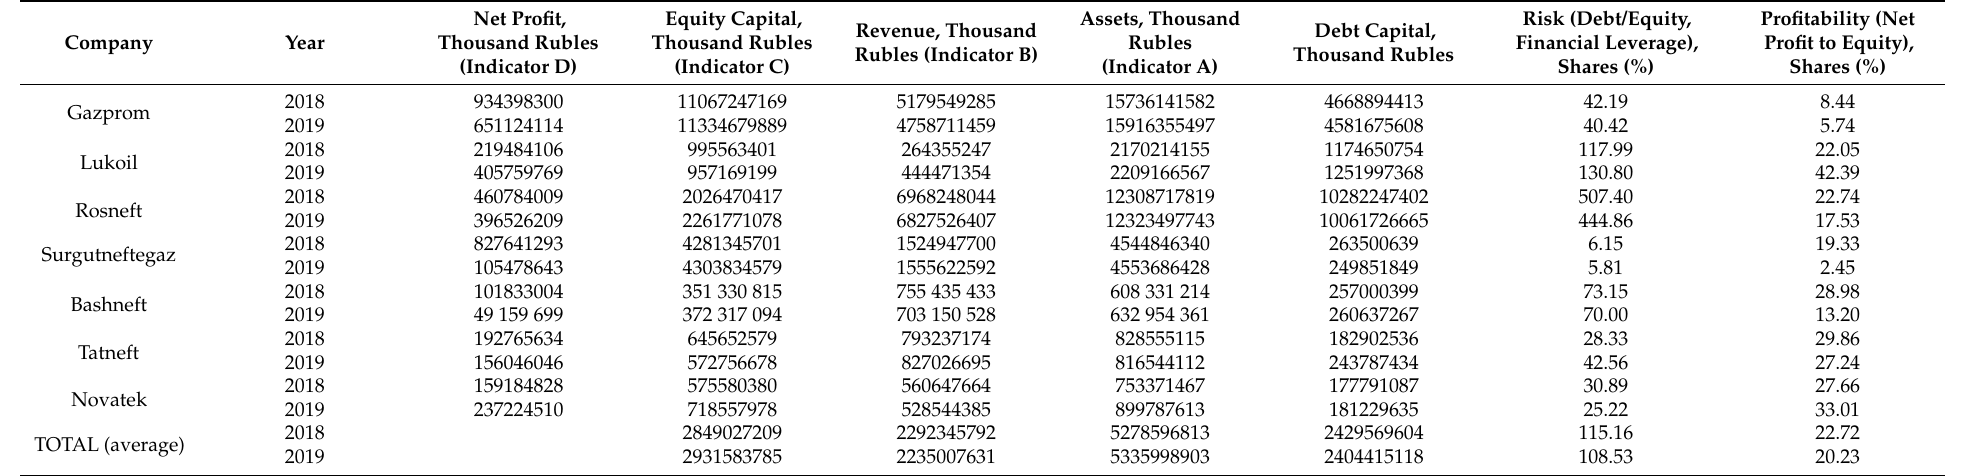
Table 1. Initial data and analysis of average values for the selected indicators.